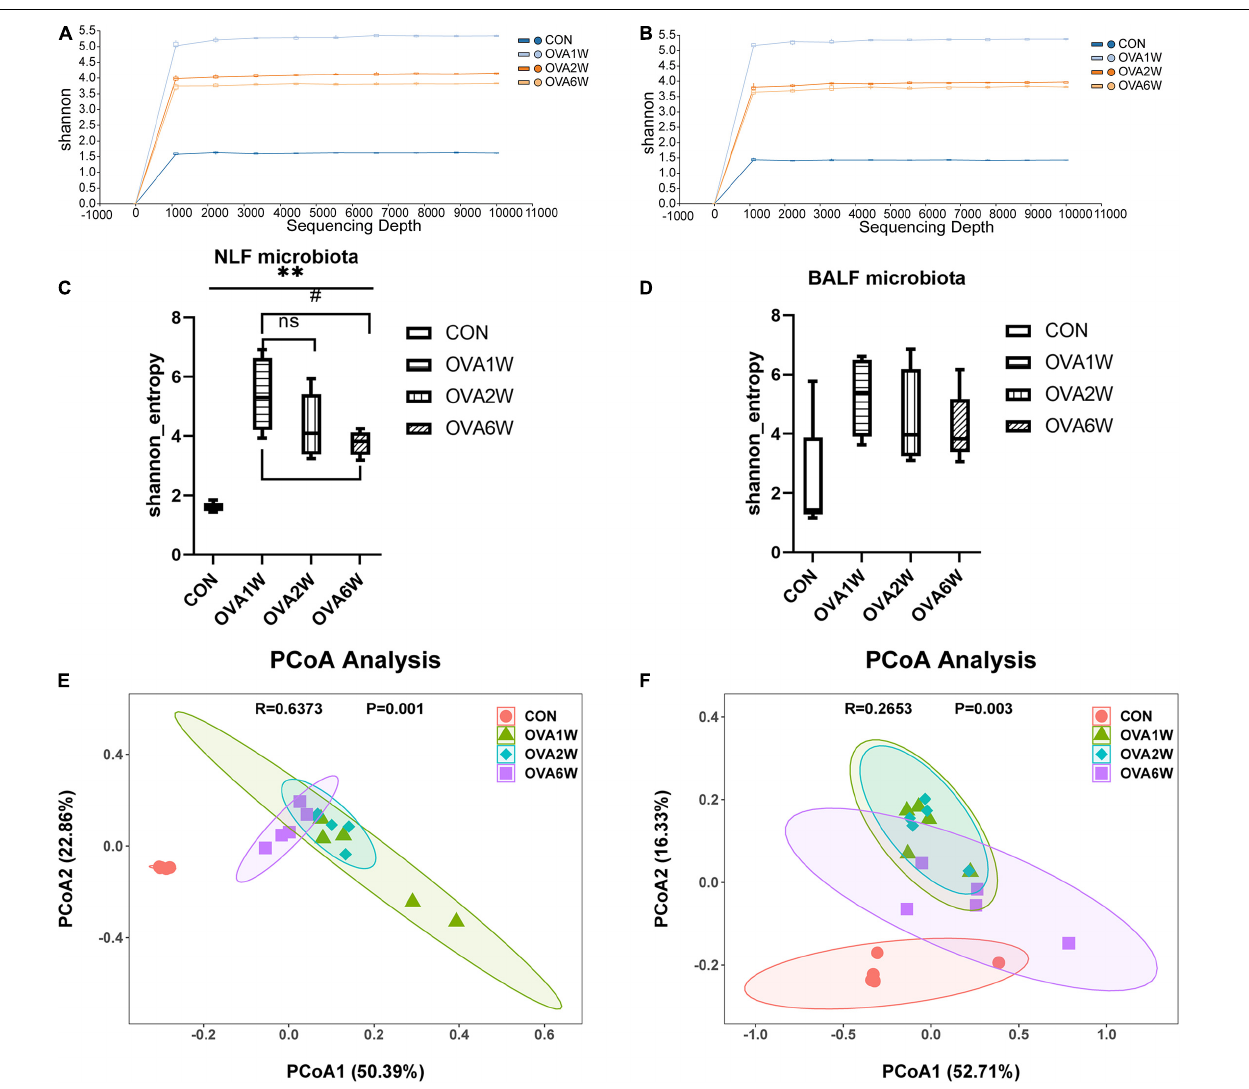
FIGURE 3 | Diversity of the respiratory microbiota in mice with OVA-induced chronic asthma. (A) The alpha rarefaction curve in NLF microbiota; (B) The alpha rarefaction curve in BALF microbiota; (C) α diversity analysis (using Shannon index) of the NLF microbiota; (D) α diversity analysis (using Shannon index) of the BALF microbiota; (E) PCoA plot showing the β diversity of NLF microbiota ( P = 0.001); (F) PCoA plot showing the β diversity of BALF microbiota ( P = 0.003). PCoA of all samples using weighted UniFrac distance. PCoA, principal coordinates analysis. ( n = 5 in each